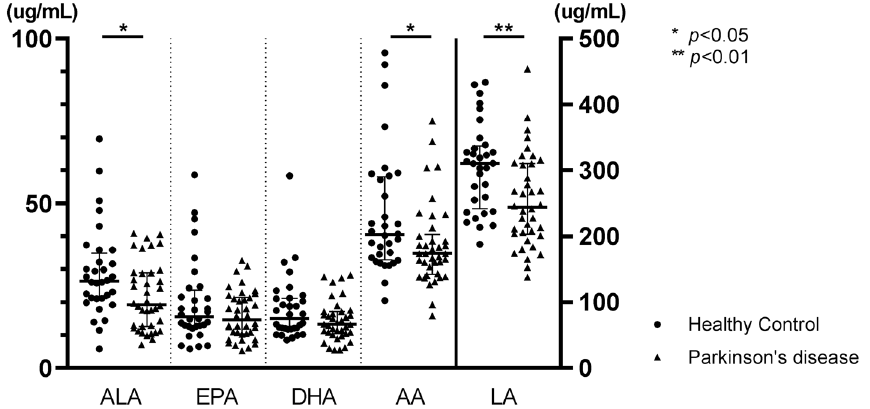
Figure 1. Plasma polyunsaturated fatty acid concentrations in Parkinson’s disease. ALA alpha-linolenic acid, EPA eicosapentaenoic acid, DHA docosahexaenoic acid, LA linoleic acid, AA arachidonic acid.